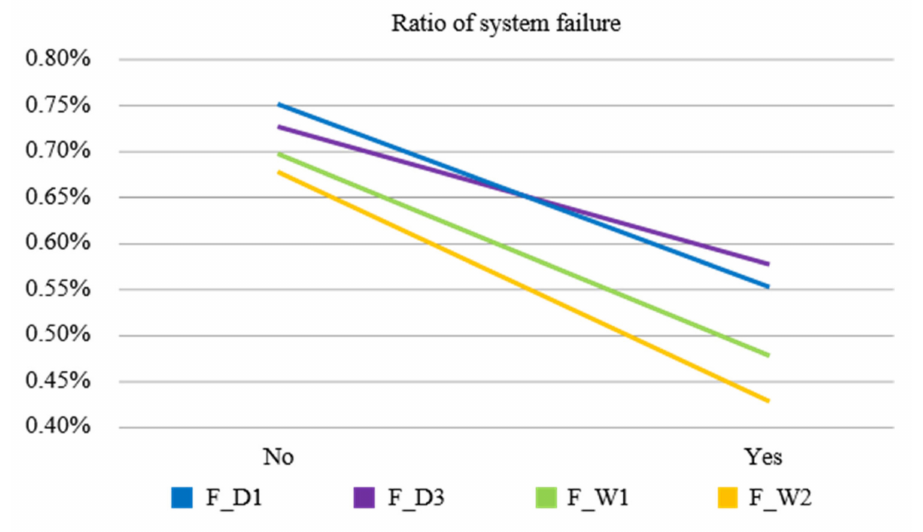
Figure 7. Ratio of system failure.